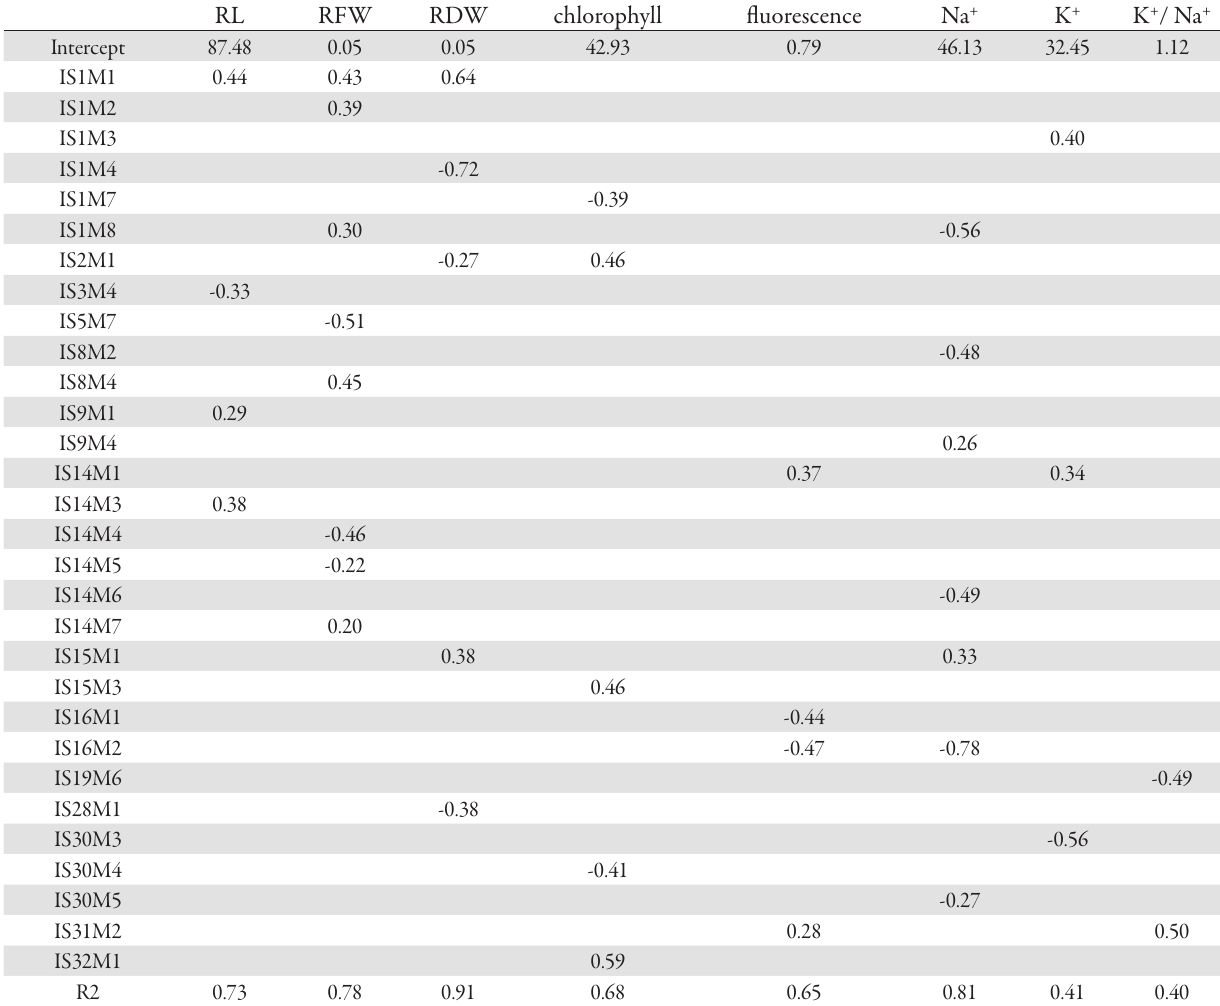
Tab. 4. Regression coefficients and adjusted R square in the multiple regression between the agronomic triats and location ISSR gene in 140 mM NaCl